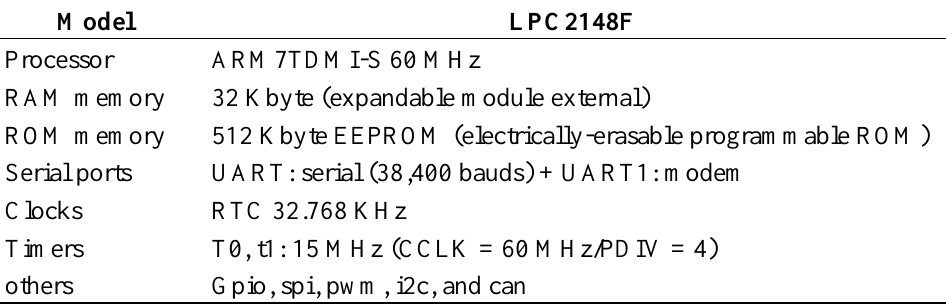
Table 1. Summary of LPC2148F specifications.